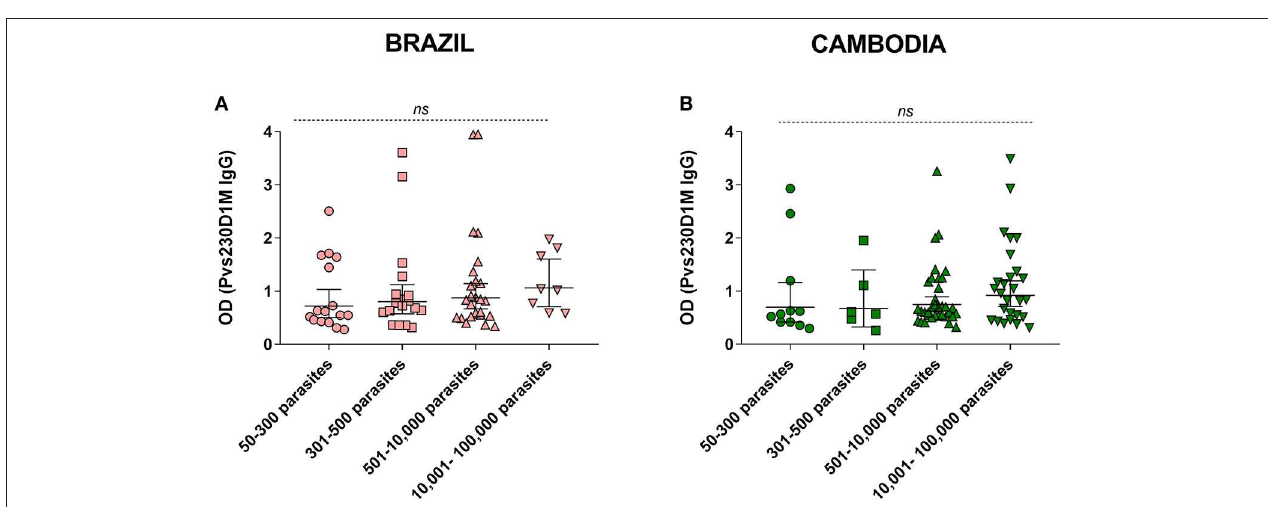
FIGURE 5 | Parasitemia levels in comparison to Pvs230D1M IgG titers in (A) Brazil and (B) Cambodia. Kruskal-Wallis analysis revealed no significant difference between the groups. Detailed information on parasitemia levels for each subject is reported in Table S1 .